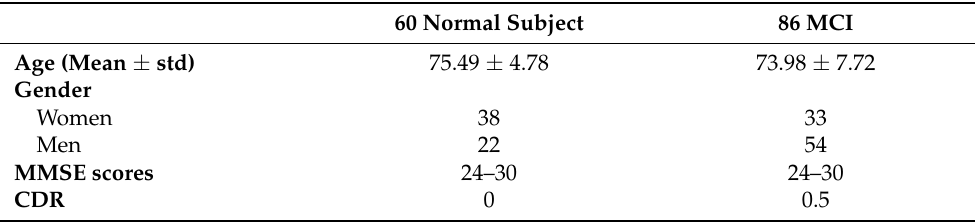
Table 1. Demographic data relating to baseline sMRI scans selected from ADNI. Note: MMSE is the Mini Mental State Examination, and CDR is the Clinical Dementia Rating.